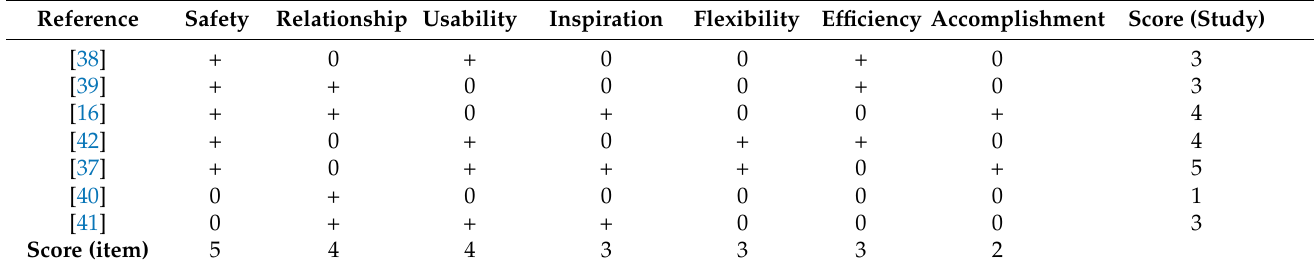
Table 3. UX goals for the designing of cobots derived from the systematic literature